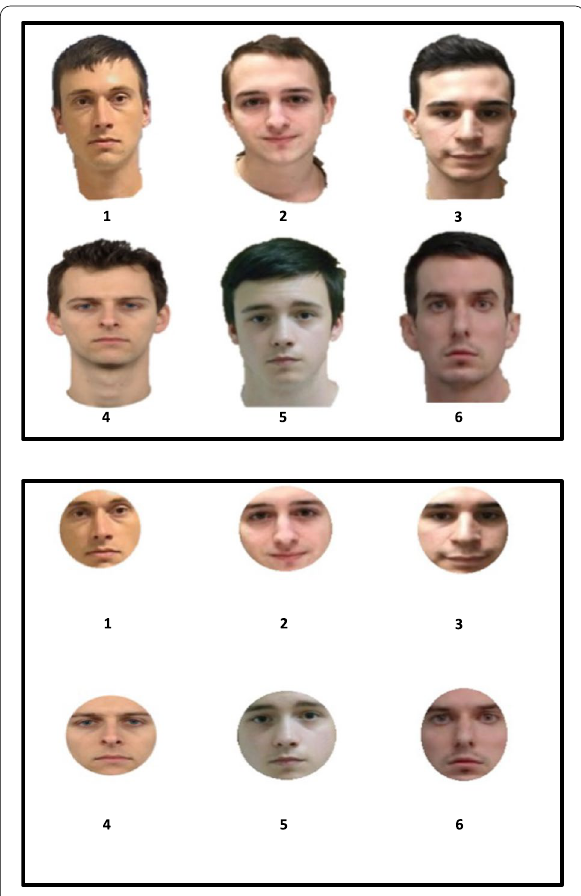
Fig. 1 Top panel is an example full face lineup with Target 1 in Position 4. The bottom panel is the same lineup with the external facial areas removed. The internal faces were presented as the same size and position as they are in the full